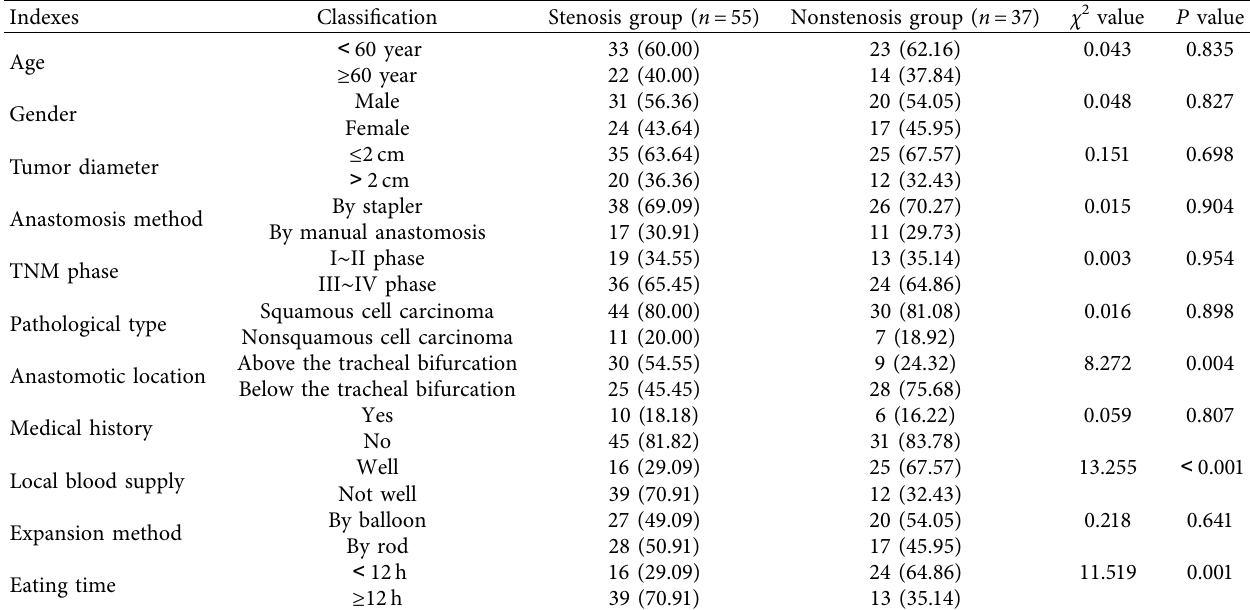
Table 1: Comparison of the general information of the two groups.